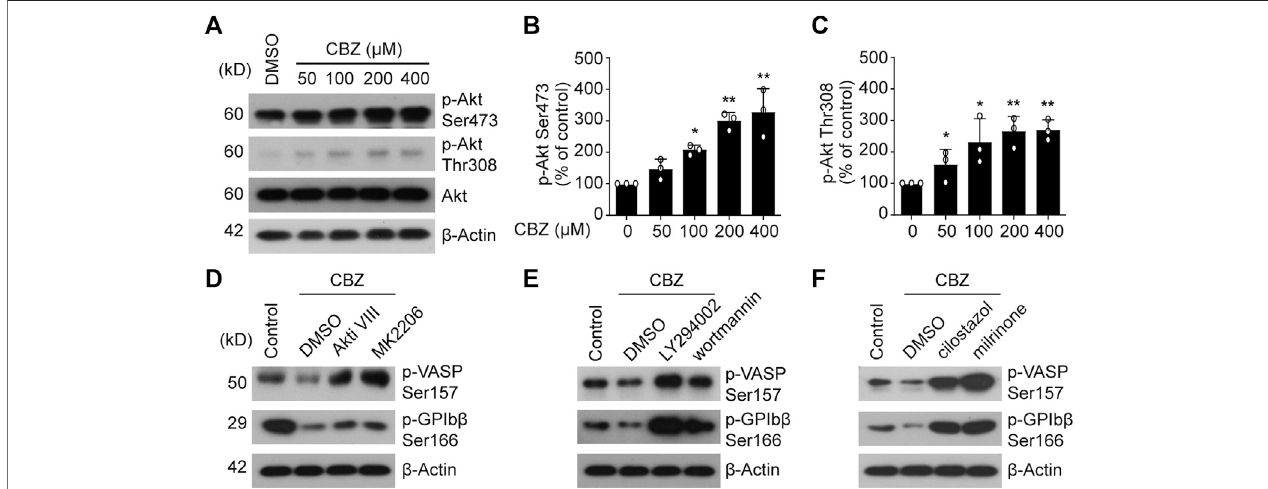
FIGURE 4 | PI3K/Akt/PDE3A signaling pathway plays an essential role in CBZ-reduced PKA activity. (A) The expression of p -Akt Ser-473 and Thr-308 were detected by Western blot analysis from human platelets incubated with CBZ or vehicle at 37 ° C for 8 H; (B,C) Histogram showing the relative normalized expression for each phosphorylated protein; n (cid:2) 3. * p < 0.05, ** p < 0.01, compared with control, one-way ANOVA. (D – E) Washed human platelets were pretreated with Akt inhibitors (D) MK2206 (6 μ M) and Akti Ⅷ (2 μ M), PI3K inhibitors (E) LY294002 (20 μ M) and wortmannin (100 nM), PDE3A inhibitors (F) milrinone (10 μ M) and